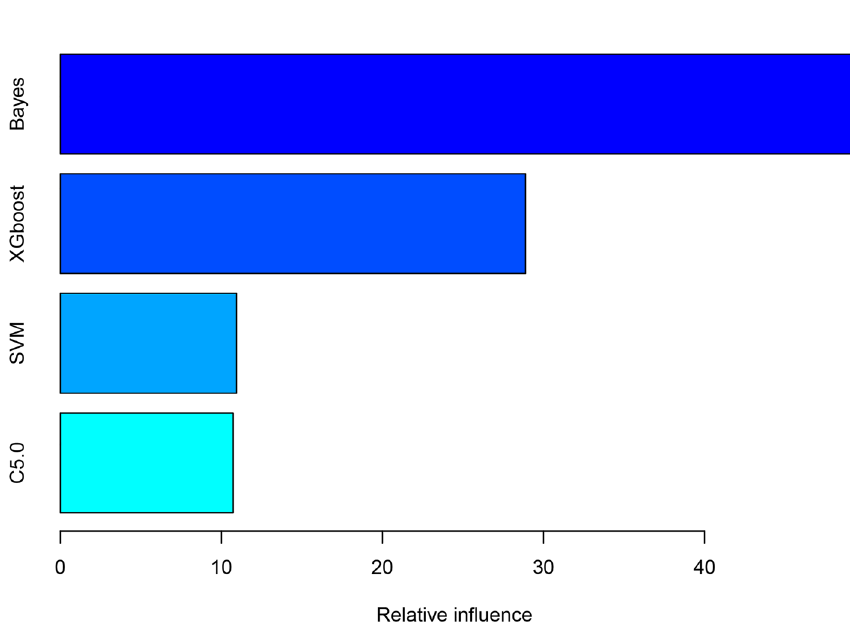
Figure 2. Relative influence of each machine learning model in the stacked-ensemble model. SVM, support vector machine; XGBoost, extreme gradient